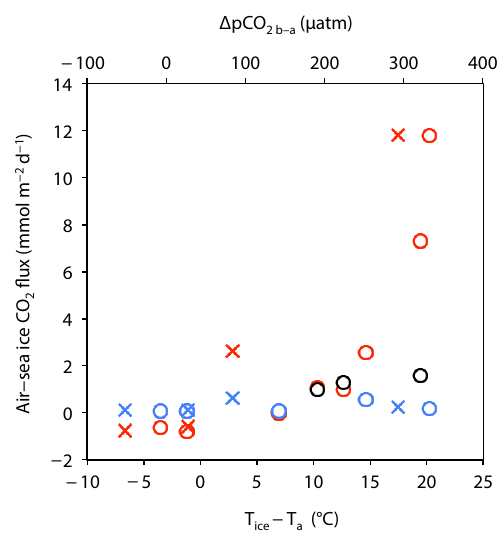
Figure 6. Relationships between mean air–sea ice CO 2 fluxes and temperature difference ( T ice – T a ) between ice (top 20cm) ( T ice ) and atmosphere ( T a ) (circle) for F snow (blue), F ff (black), and F ice (red) for young and first-year sea ice. Relationships between mean air– sea ice CO 2 fluxes and the difference of p CO 2 ( (cid:49)p CO 2b − a ) be- tween brine ( p CO 2b ) and atmosphere ( p CO 2a ) (cross) for F snow (blue) and F ice